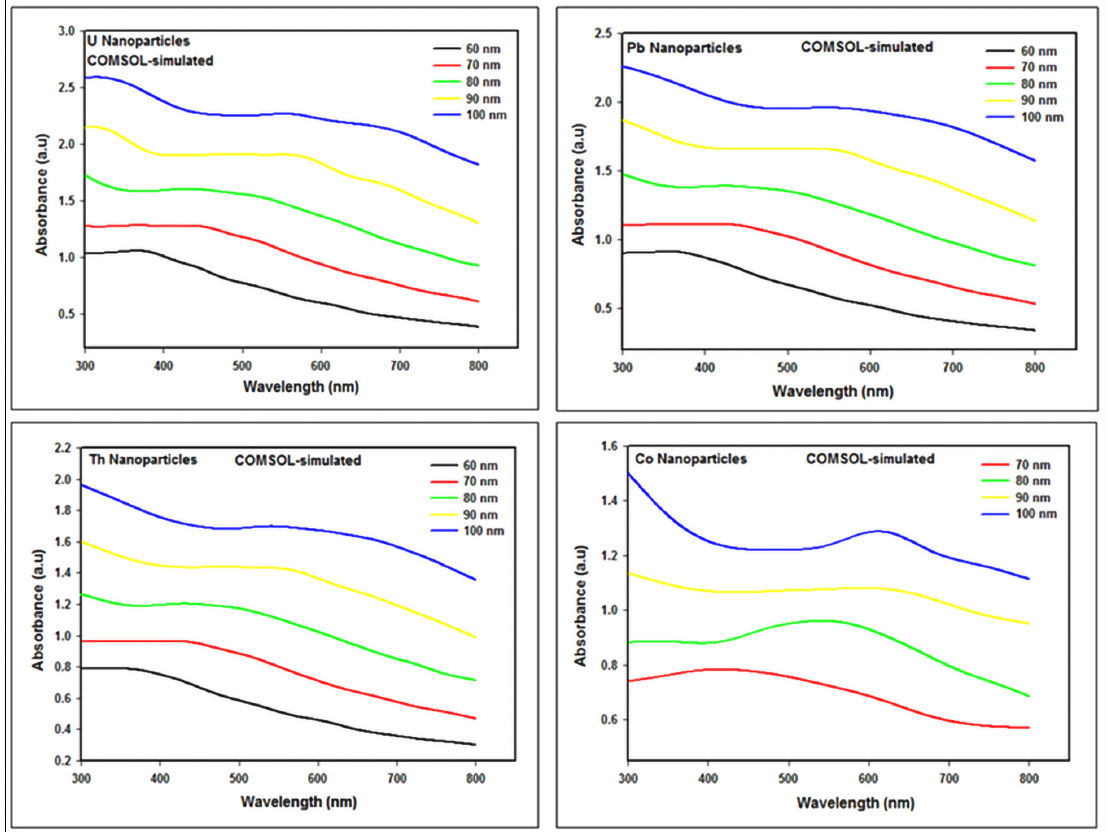
Figure 5. COMSOL ‐ simulated absorption spectra of U, Pb, Co, and Th nanoparticles. Figure 5. COMSOL-simulated absorption spectra of U, Pb, Co, and Th Table 1. The COMSOL ‐ simulated maximum absorption peak of U, Pb, Co, and Th nanoparticles for different particles size.